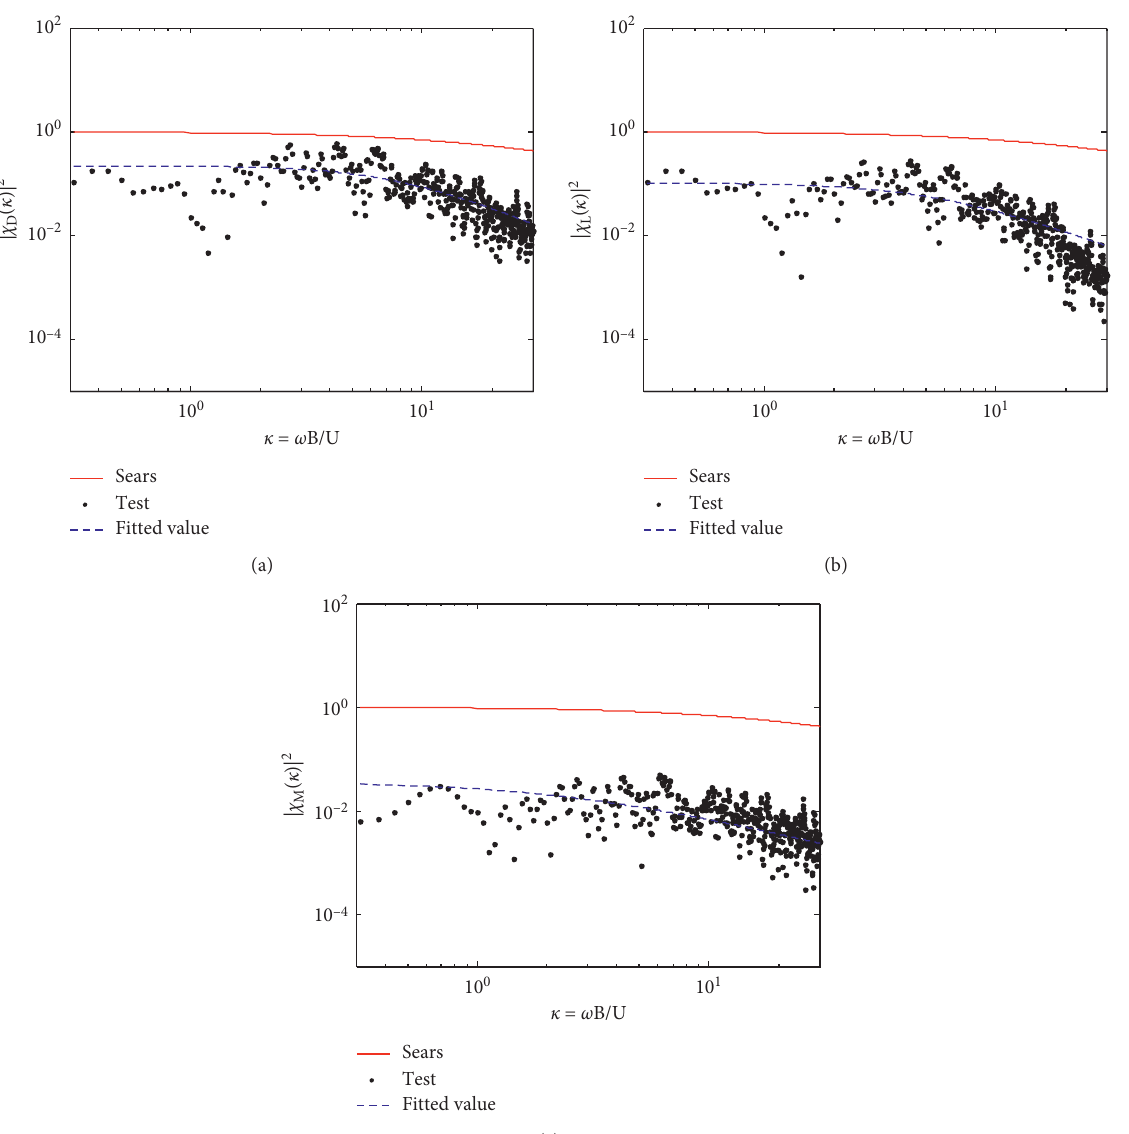
Figure 7: Experimentally tested aerodynamic admittance functions (AAFs) of Case 1 at the angle of attack (AoA) 0 ° : (a) | χ (c) | χ M | 2 .